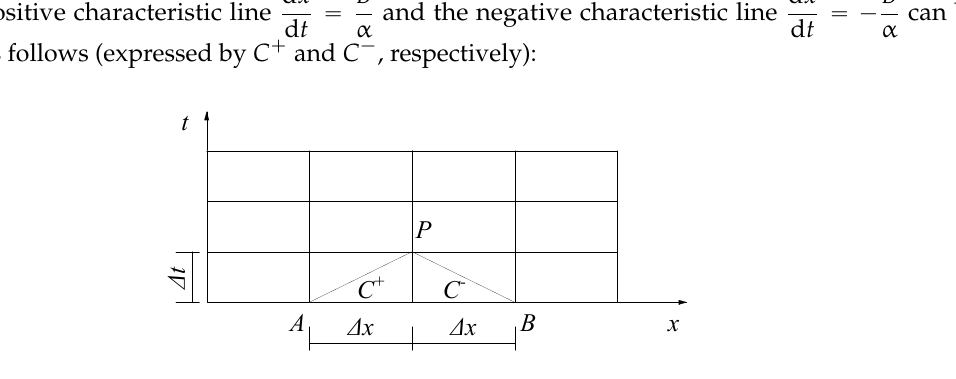
Figure 2. The characteristic grids and characteristic lines.